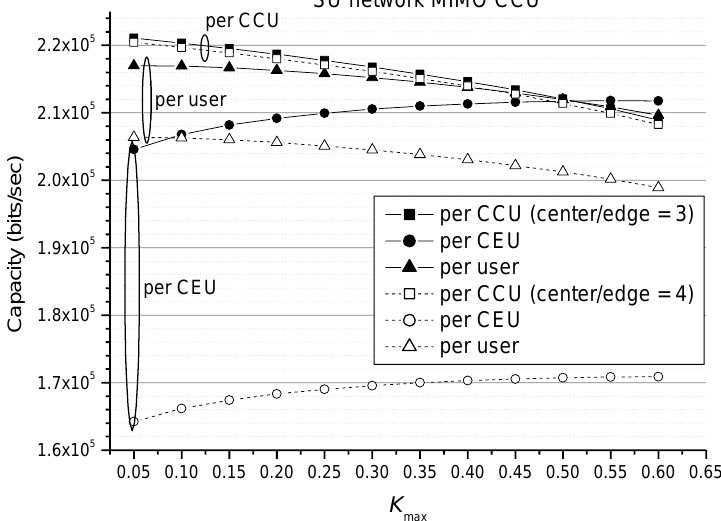
Figure 16. Capacity comparison between different values of center-edge area ratio for SU-network MIMO.